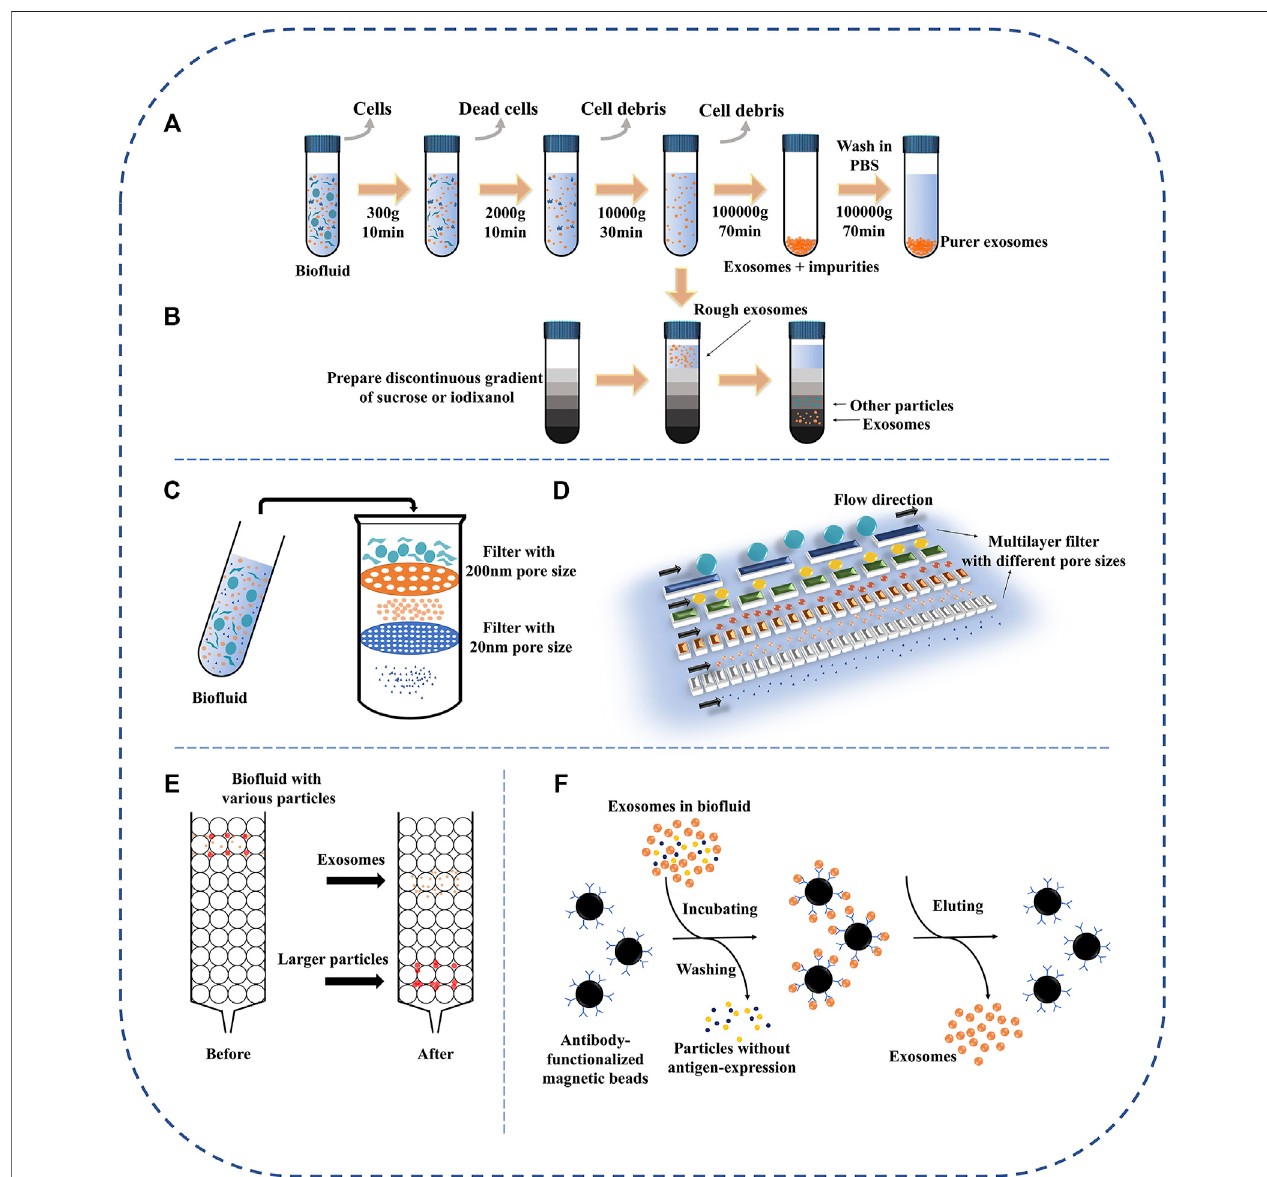
FIGURE 4 | Schematic representation of common exosomal separation techniques. (A) Ultracentrifugation, (B) Density gradient centrifugation, (C) Dead-end fi ltration (DEF), (D) Tangential fl ow fi ltration (TFF), (E) Size-exclusion chromatography, and (F) Immunoaf fi nity.